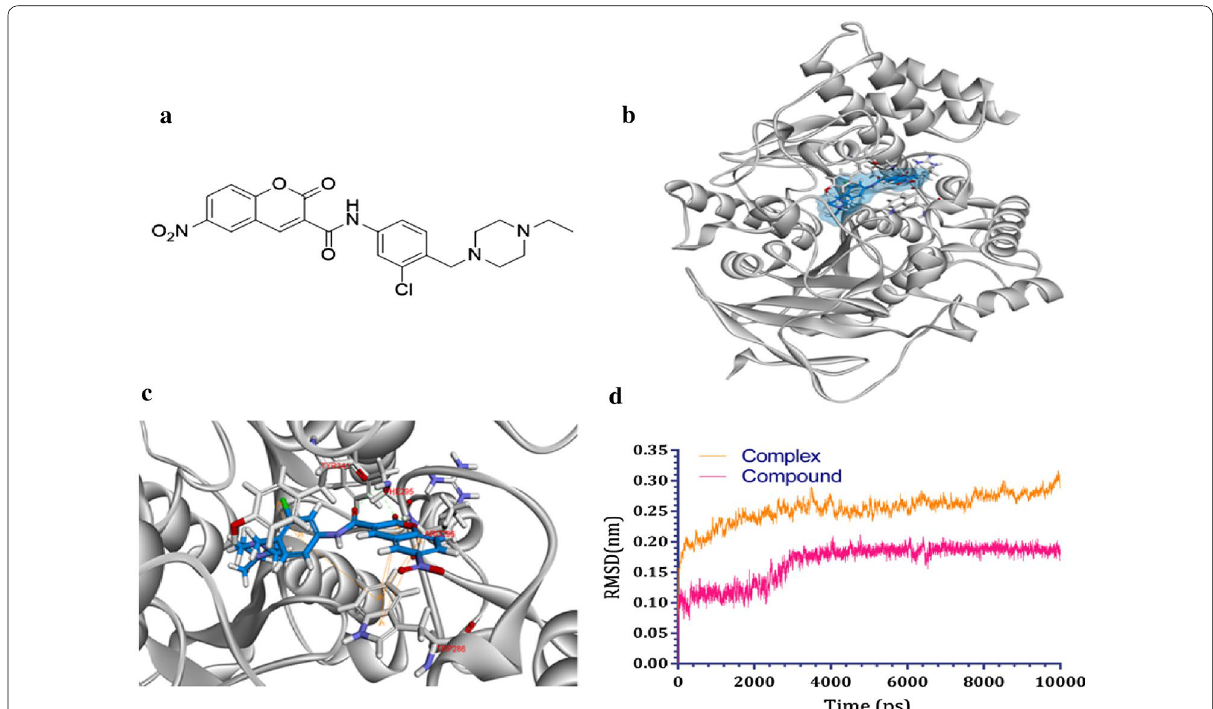
Fig. 52 Molecular modelling, docking and molecular dynamics (MD) simulations of AChE targeting compound C48 -AChE. a Molecular structure of compound C48 . b Molecular docking of compound C48 . c The interactions of compound C48 and active pocket. d Molecular dynamics of compound C48 -AChE complex